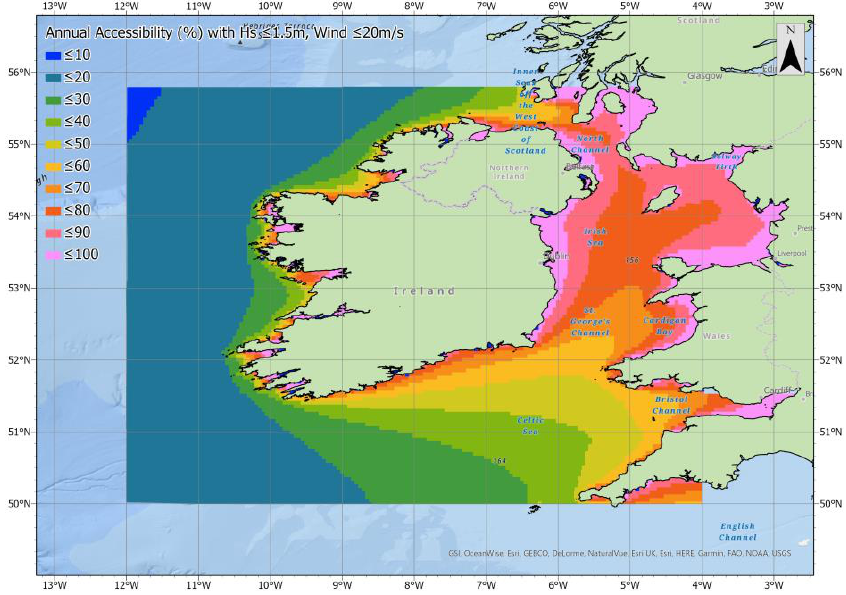
Figure 11. Annual accessibility (%) based on CTV operating limits of 1.5 m H s and 20 m/s wind speed.